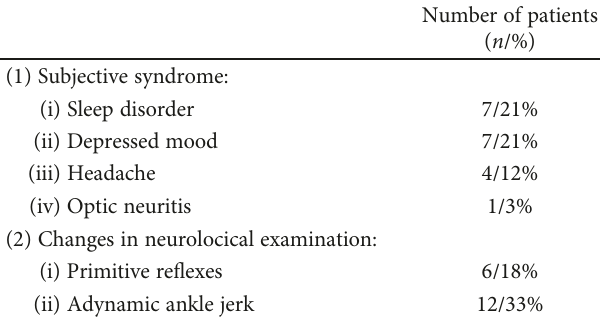
Table 2: Neurological assessment.